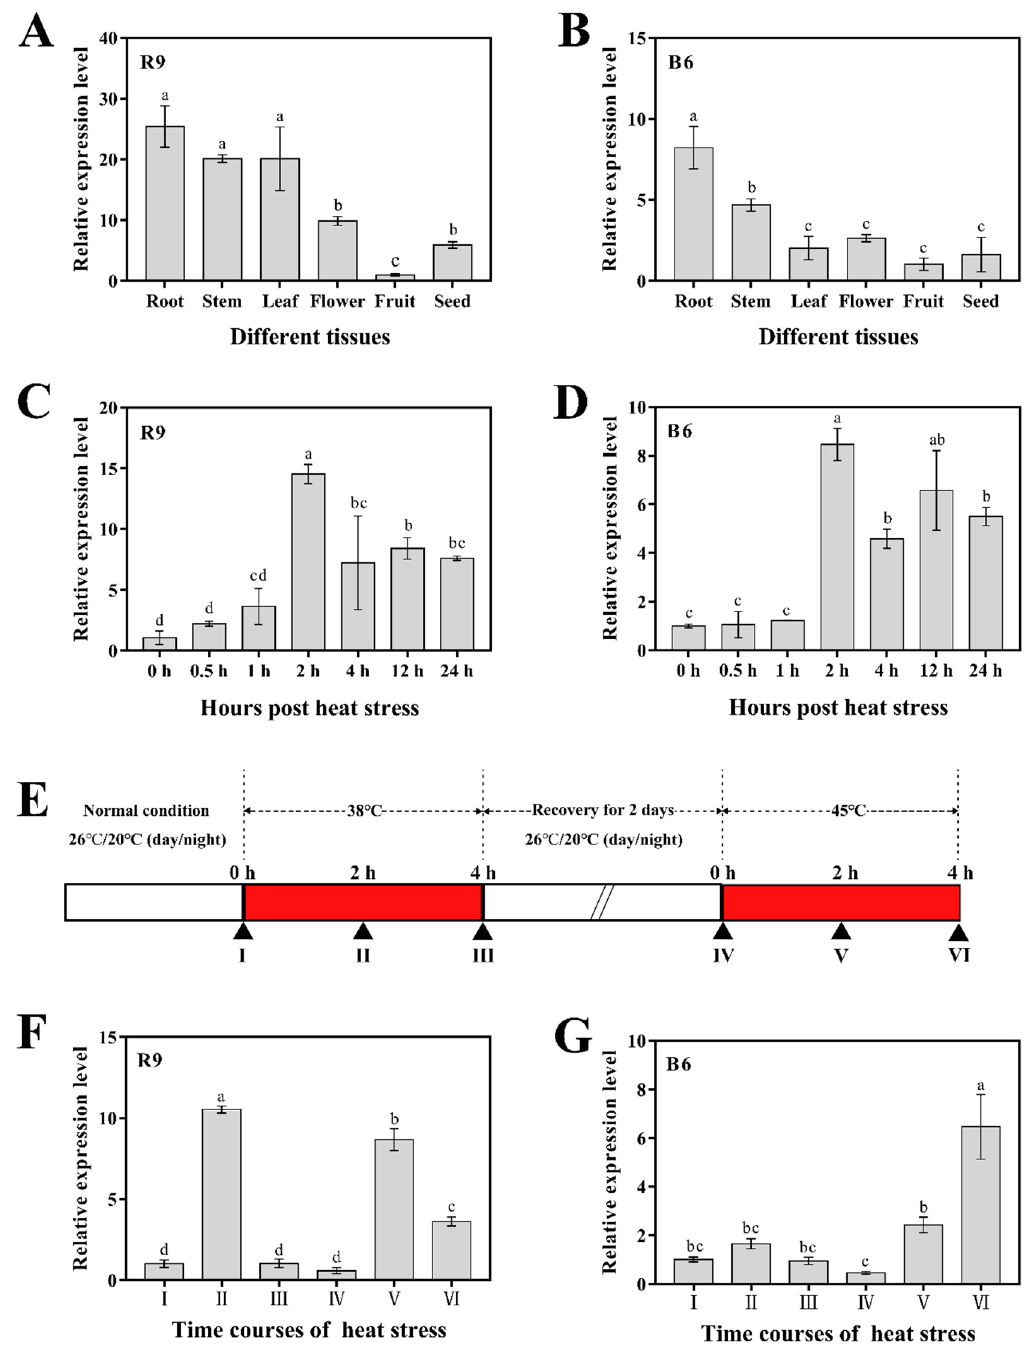
Figure 4. The CaHsfA1d expression in different tissues and response to heat treatment. ( A , B ) Tissue-specific expression levels of CaHsfA1d in pepper line R9 or B6. The expression level in fruit was set as 1. ( C , D ) The CaHsfA1d expression analysis in pepper BT in the R9 or B6 leaves. ( E ) Schematic representation of the heat stress regimes of Figure F,G. ( F , G ) The CaHsfA1d expression analysis in pepper AT in the R9 or B6 leaves. Pepper CaUBI3 (ubiquitin-conjugating protein-coding gene) is used as a reference gene to normalize the transcript levels of CaHsfA1d upon different samples. The expression at 0 h is set as 1. Data are means ±SD of three biological replicates. Different lowercases letters denote statistically significant differences from the control treatment at p ≤ 0.05 by t -test.